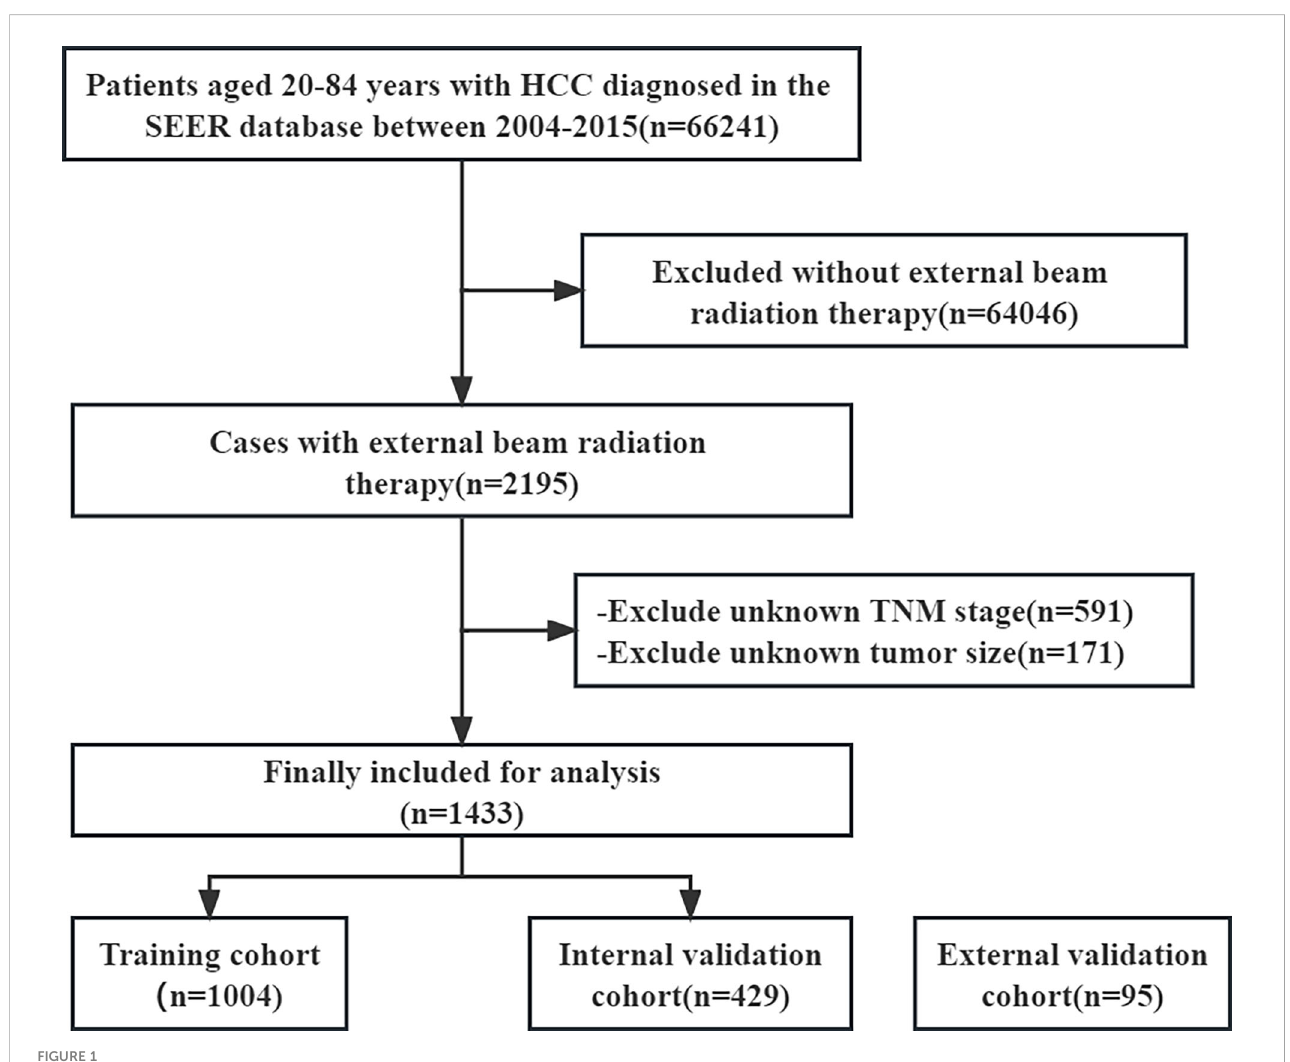
FIGURE 1 The fl owchart of patient inclusion among the SEER